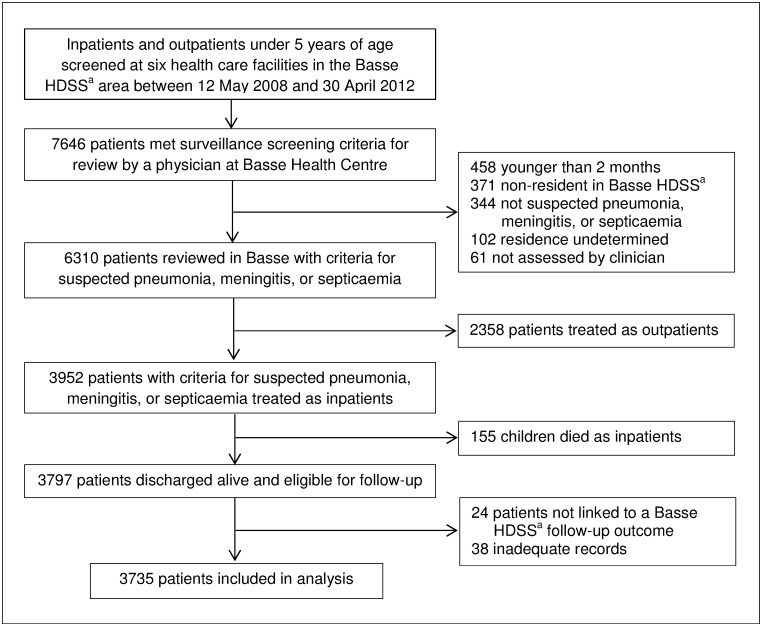
Flow diagram showing the study profile of patient enrolment, inclusion and exclusion, and loss-to-follow-up.This flowchart shows the numbers of participants who were screened, met criteria for enrolment, discharged alive and included in analysis. aBasse Health and Demographic Surveillance System (Basse HDSS).